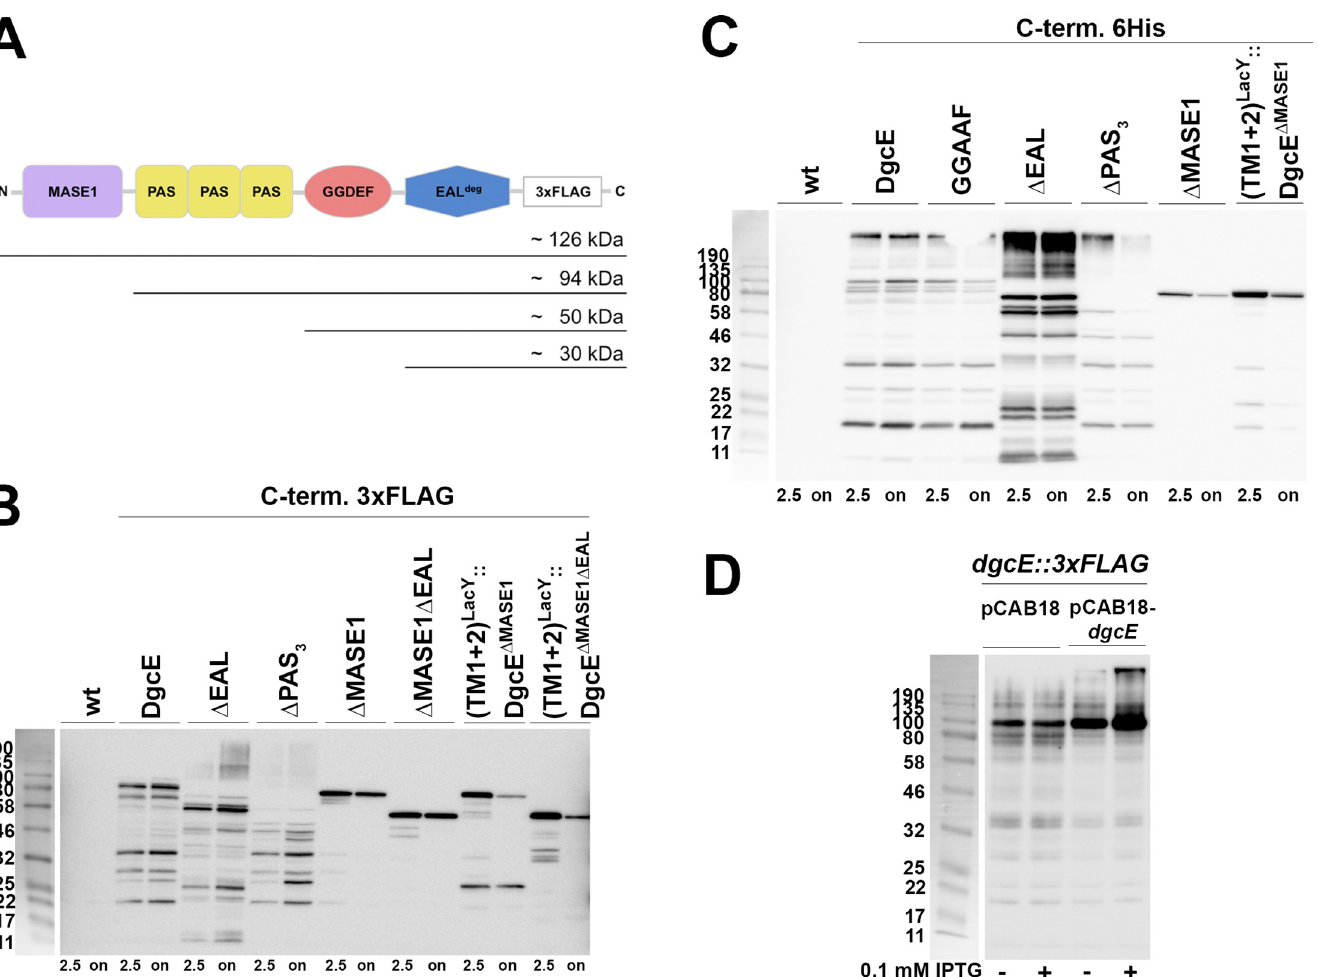
Fig 3. DgcE is subject to proteolytic turnover that proceeds from the N-terminal MASE1 domain to the C-terminal EAL domain. A: size of expected proteolytic fragments obtained by degradation starting from the N-terminus of DgcE and pausing between domains. B: Immunoblot analysis of chromosomally encoded C- terminally 3xFLAG-tagged DgcE variants in derivatives of strain W3110, with samples taken at an OD 578 of 2.5 and after overnight growth (on). C: Immunoblot analysis performed as in (B), but with the indicated DgcE variants expressed from the low copy number plasmid pCAB18 with a C-terminal 6His tag visualized using anti-6His antibodies. D: Immunoblot detecting chromosomally encoded 3xFLAG-tagged DgcE expressed concomitantly with DgcE expressed from plasmid pCAB18 in the absence or presence of the inducer isopropyl-thio-galactoside (IPTG).